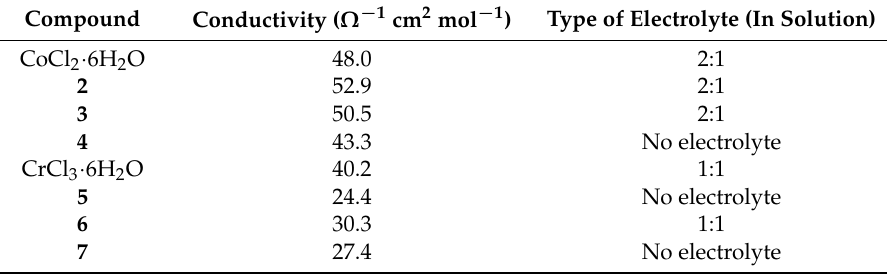
Table 1. Electrical conductivity for 2 – 7 and starting salts.